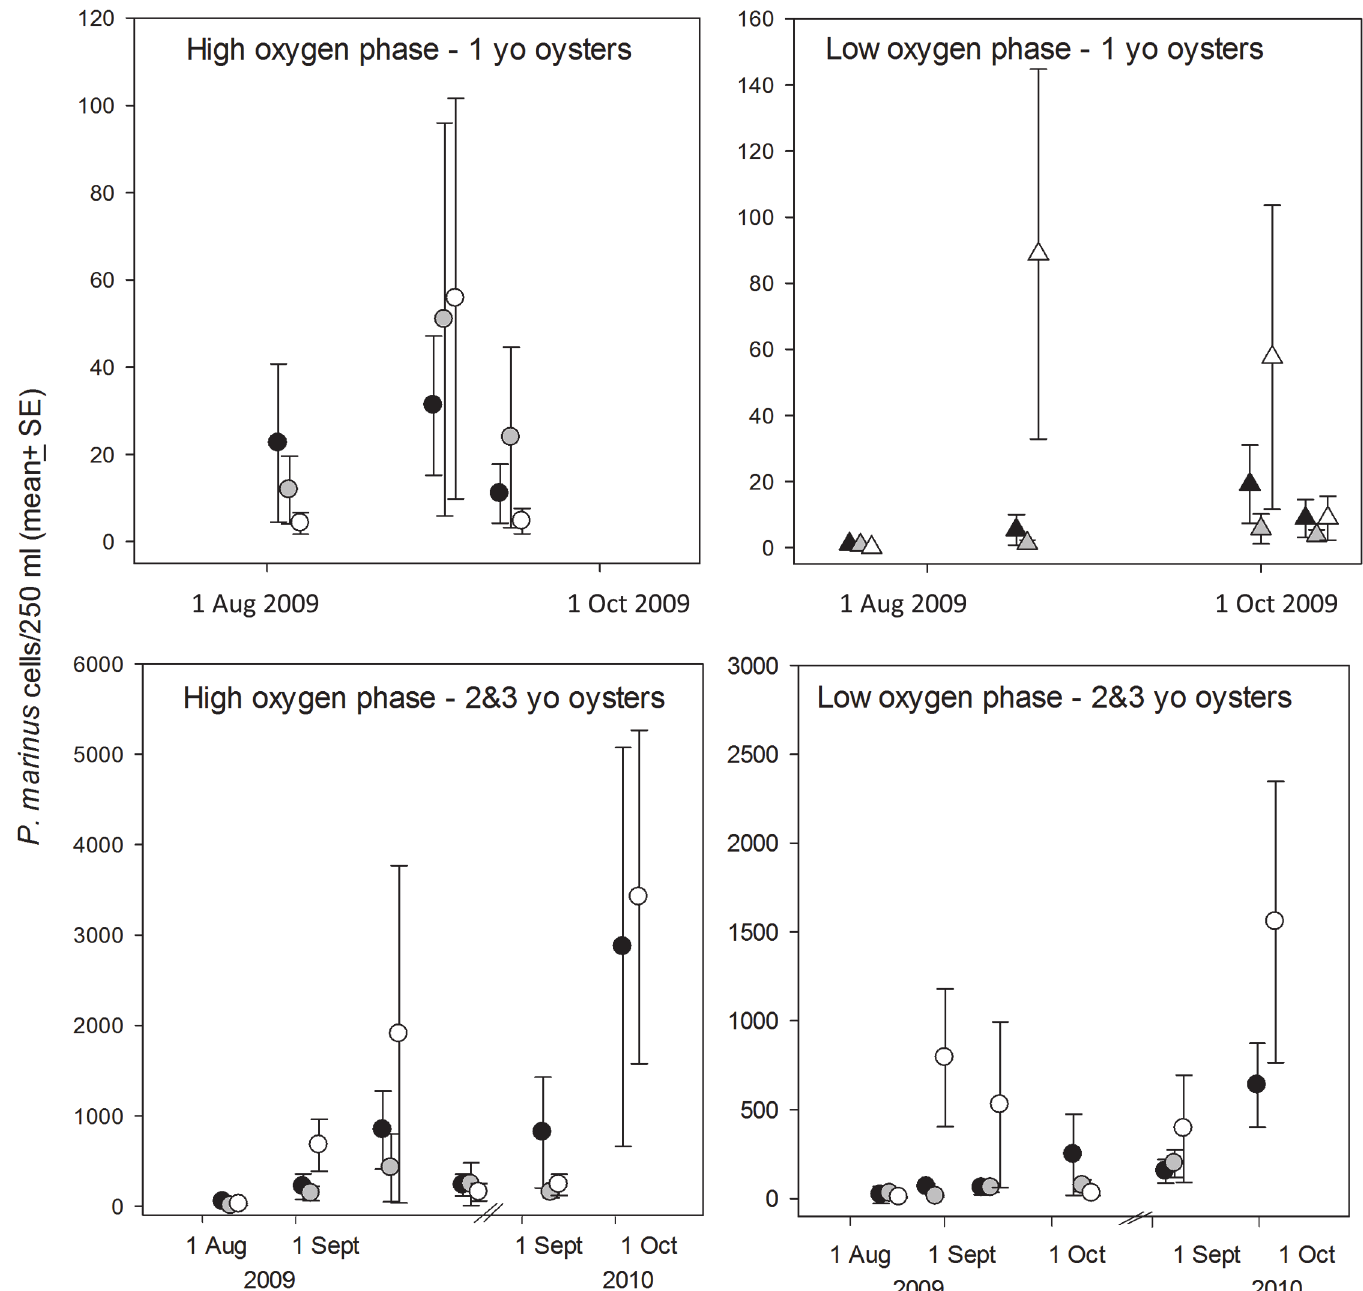
Fig 8. Densities of waterborne P . marinus cells in experimental aquaria based on qPCR assays. Symbols: black = 0.5 mg l -1 tanks; grey = 1.5 mg l -1 tanks; white = high oxygen control tanks.